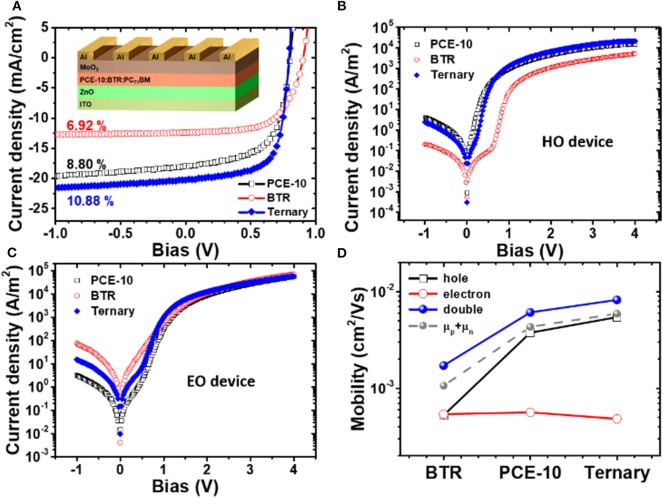
(A) Current density vs. voltage (J-V) characteristics of BHJ-OSCs based on photo-active layers of PCE-10:PC71BM, BTR:PC71BM binary blends, and PCE-10:BTR:PC71BM ternary blends. Dark J-V curves of (B) hole-only (HO) and (C) electron-only (EO) devices based on the same active layers of solar cells. (D) Carrier mobility of holes, electrons, and double carriers in BTR and PCE-10 binary, and ternary blends determined by single-carrier device measurements and solar cell dark current analysis. Also compared is the sum of electron and hole mobilities in single-carrier devices.